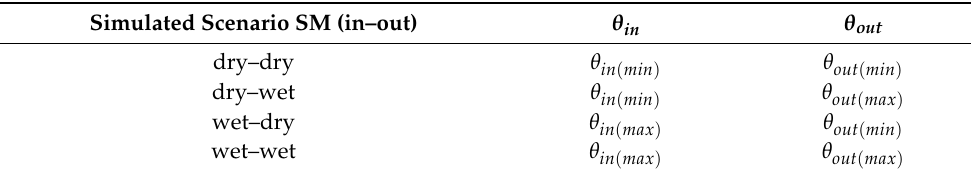
Table 1. SM combinations of the four neutron transport simulations used to perform the proposed CRNS correction